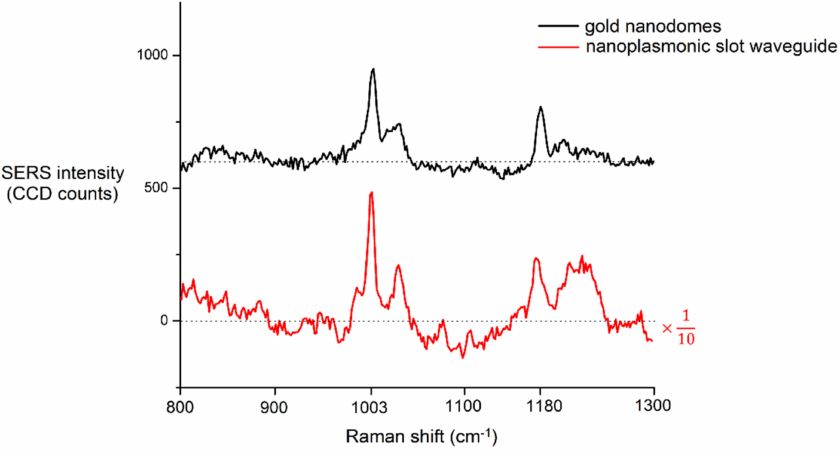
Figure 8. Background-subtracted SERS spectra of the